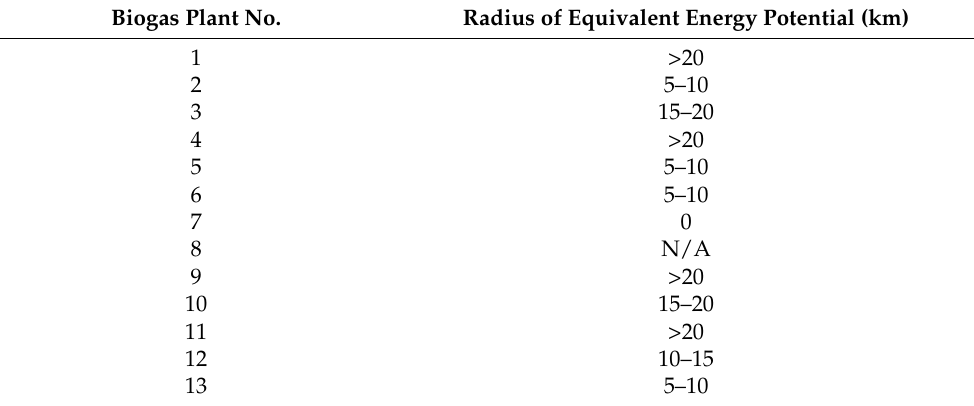
Table 4. Range of the radius of equivalent energy potential to replace maize silage. Biogas Plant